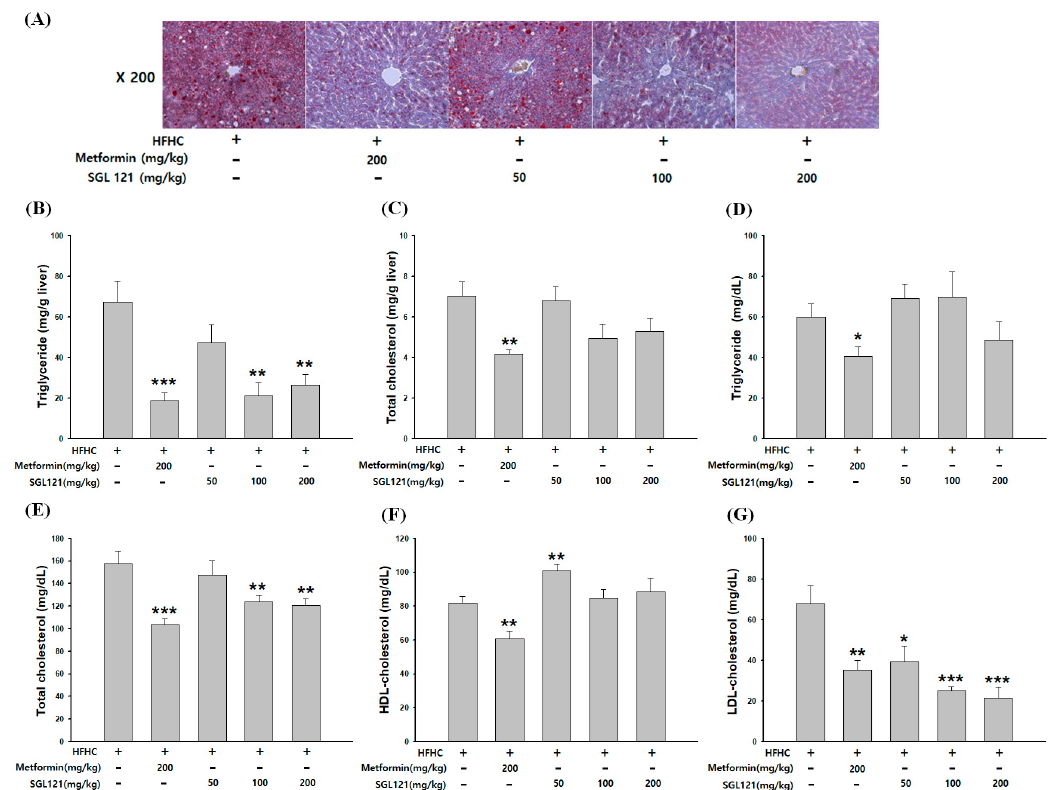
Figure 2. Effect of SGL 121 on lipid accumulation in NAFLD-induced mice. ( A ) Oil red O or hematoxylin staining of the liver, ( B ) hepatic triglyceride (TG), ( C ) hepatic total cholesterol (TC), ( D ) serum TG, ( E ) serum TC, ( F ) high-density lipoprotein (HDL) cholesterol, and ( G ) low-density lipoprotein (LDL) cholesterol levels. Data are presented as the mean ± SE, n = 8. * p < 0.05, ** p < 0.01, and *** p < 0.001 compared to the HFHC group.